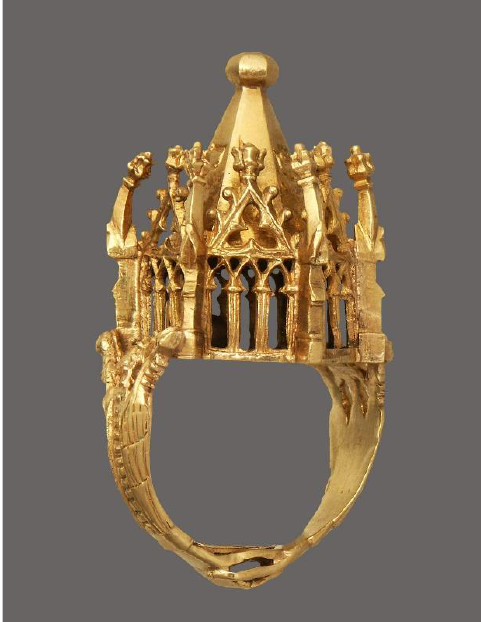
Figure 3. Erfurt Treasure. Figure 3. Jewish Wedding Ring, Erfurt Treasure (first half of 14th Century), © B. Stefan, Thuringian State Office for Heritage Management and